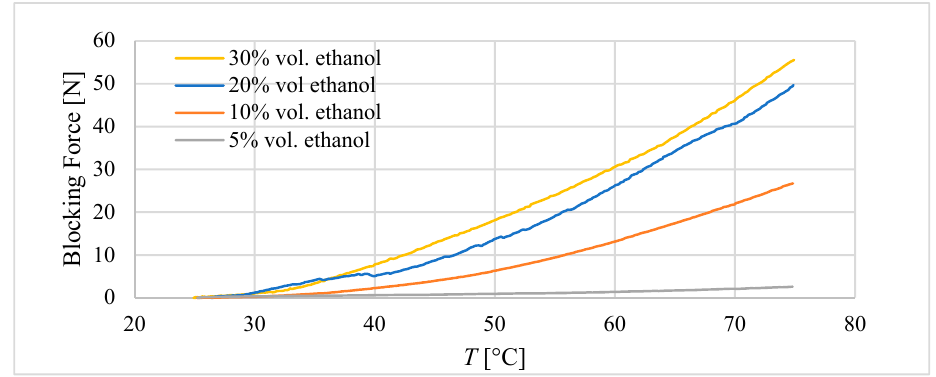
Figure 9. Blocking force of tube actuators based on a silicon-–ethanol composite with different content of ethanol. The dimensions of the composite core were diameter D = 20 mm and initial length l 0 = 40 mm.